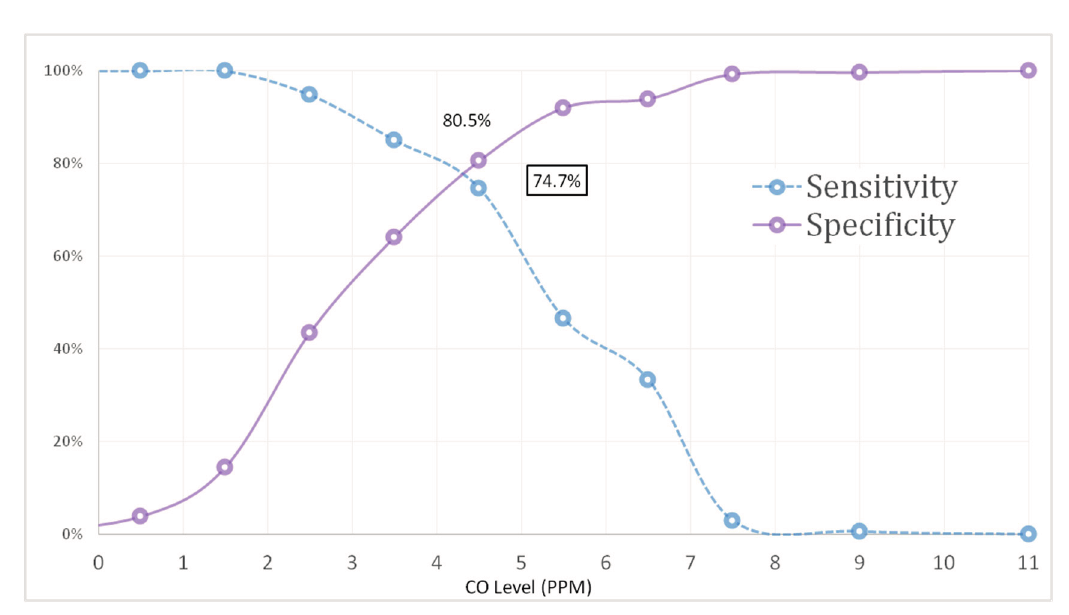
Figure 2. Sensitivity and specificity for various cut-off levels for eBCO against self-report of ever cigarette